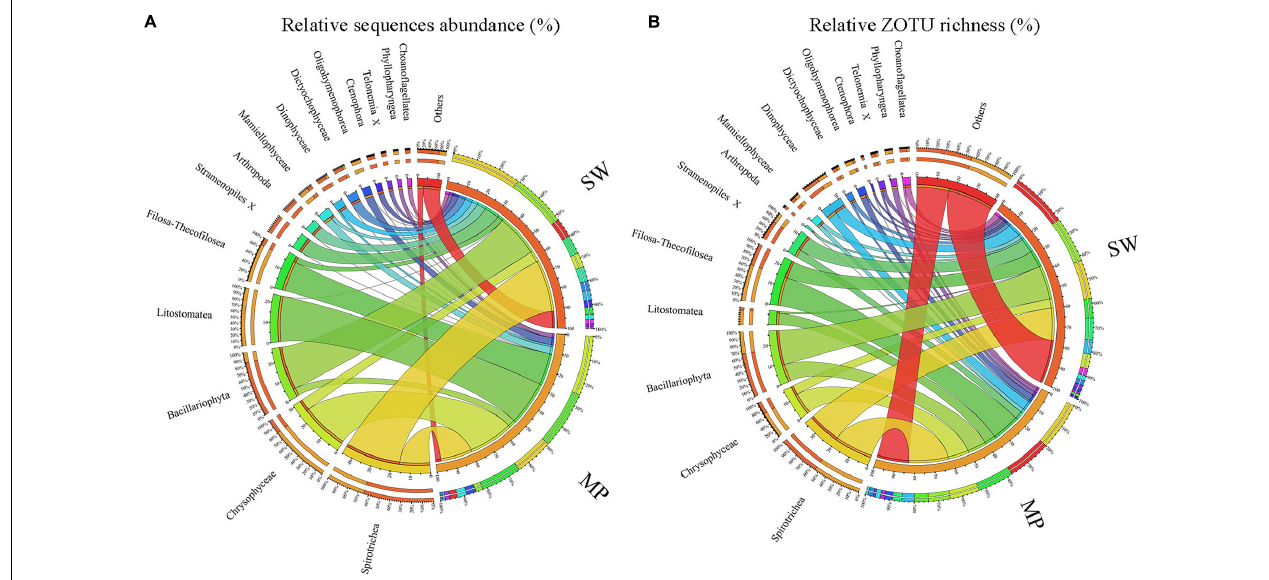
FIGURE 5 | Overview of microbial eukaryotes in the pooled sea water (SW) and melt ponds (MPs). Relative sequence abuncance (A) and relative ZOTU richness (B) ,